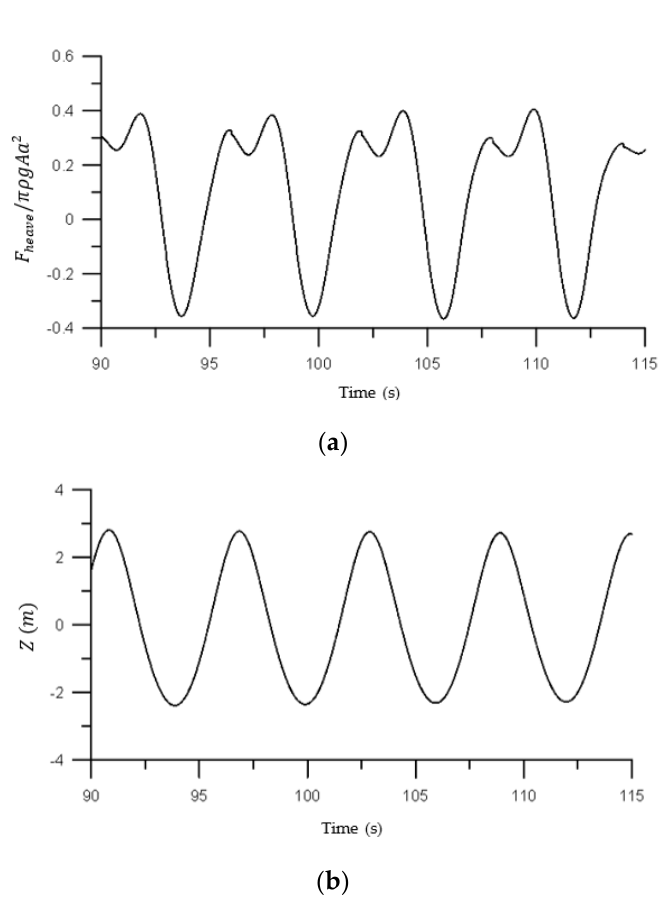
Figure 7. Time variation of the heave exciting force ( a ) and the heave motion ( b ) for the cylinder with a = 5.0 m and b / a = 1.0 ( d = 10.0 m) under the action of unit-amplitude nonlinear monochromatic waves of T = 6.0 s.